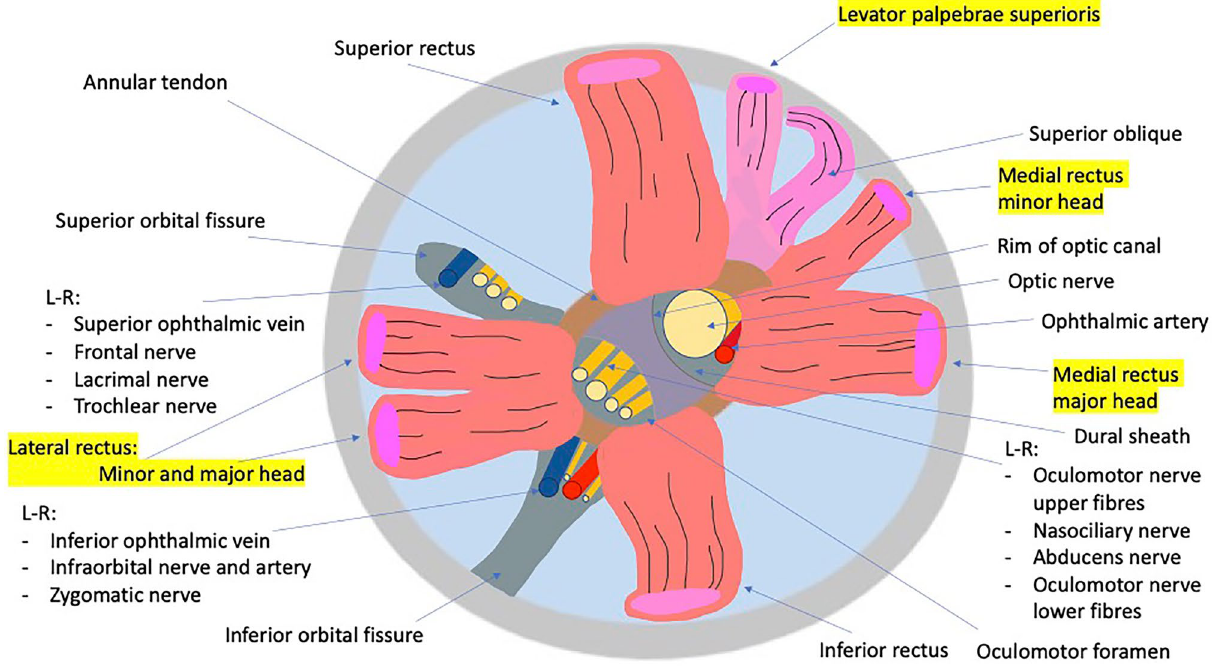
Figure 8. Changes in orbital anatomy observed during dissection compared to original